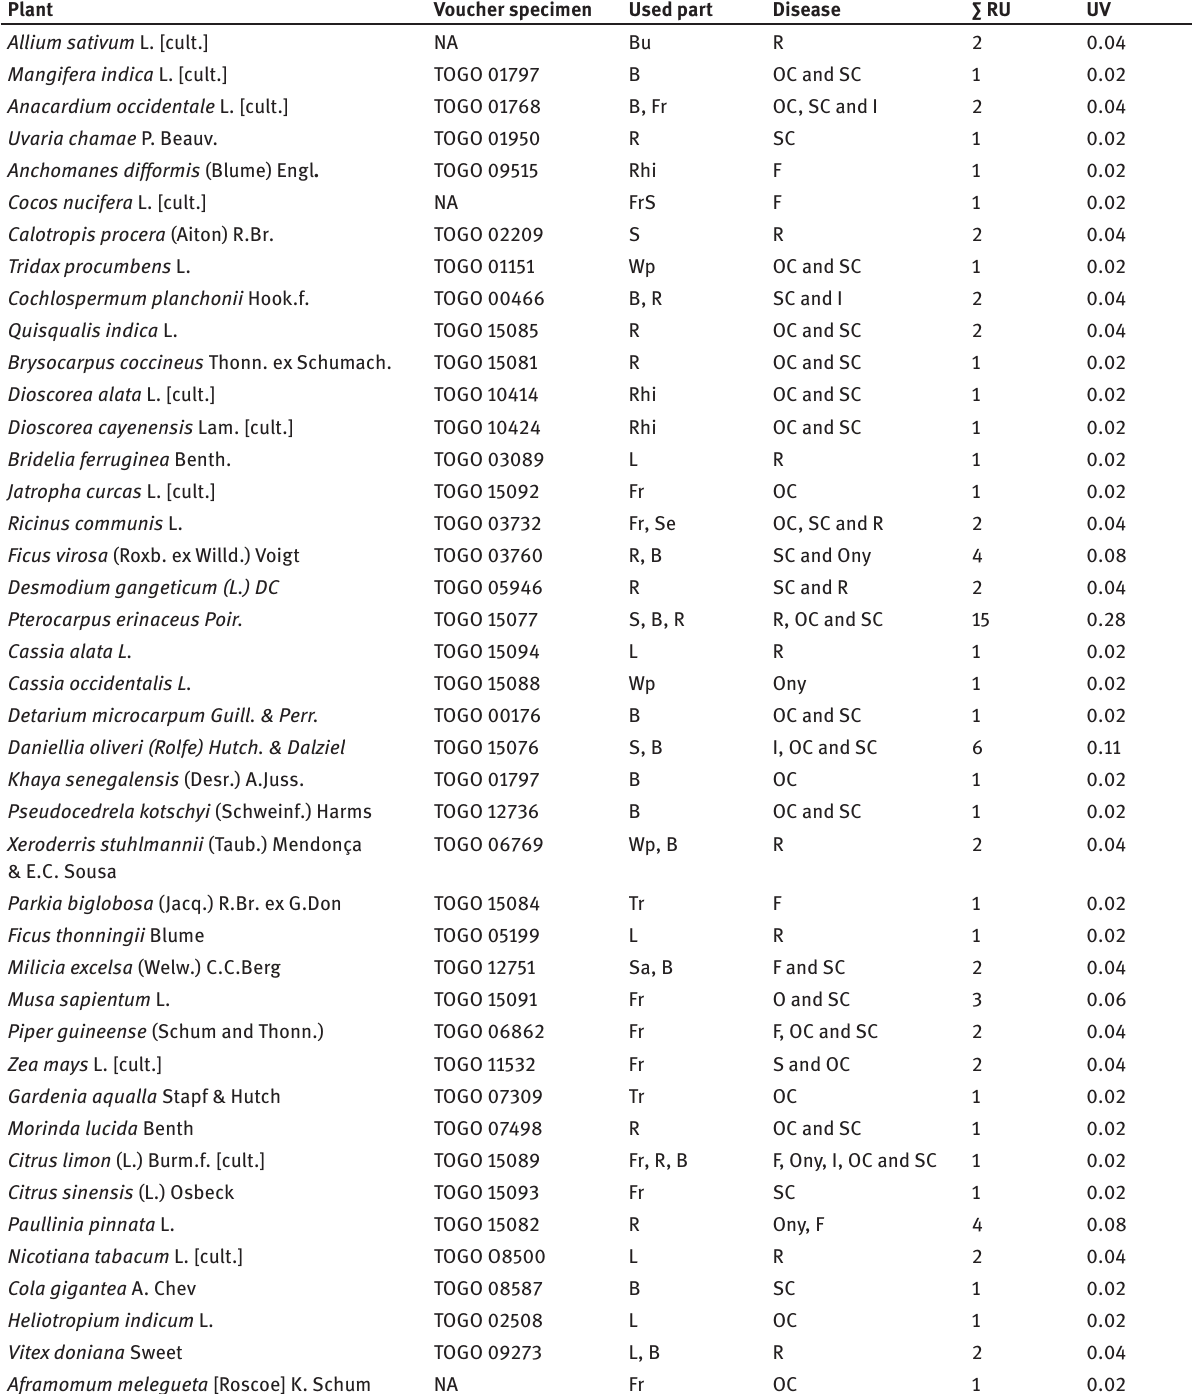
Table 1: Long list of plants obtained after the survey. Indices. ∑RU: sum of Reported Uses, UV: Use Value. Local names . Tch: Tchamba, Te: Tem, La: Lamba, K (Kounssountou), Lo: Logba, Ka: Kabyè. Type of fungal and related diseases . R: Ringworm; I: Intertrigo; OC: Oral Candidiasis; SC: Sexual Candidiasis; F: Felon; Ony: Onychomycosis. Plants parts . Bu: bulb; B: barks; Fr: fruits; FrS: fruits shell; R: roots; Rhi: rhizome; S: sap; Wp: whole plant; L: leaves; Se: seeds; Tr: Trunk. Voucher number . NA: not